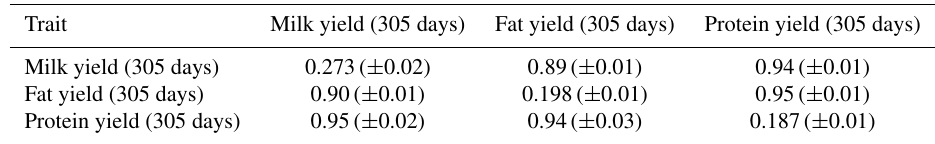
Table 4. Genetic (above diagonal) and permanent environmental (below diagonal) correlations (SD in brackets) and heritabilities (diagonal) for 305 days of milk, fat, and protein yields by Bayesian analysis.